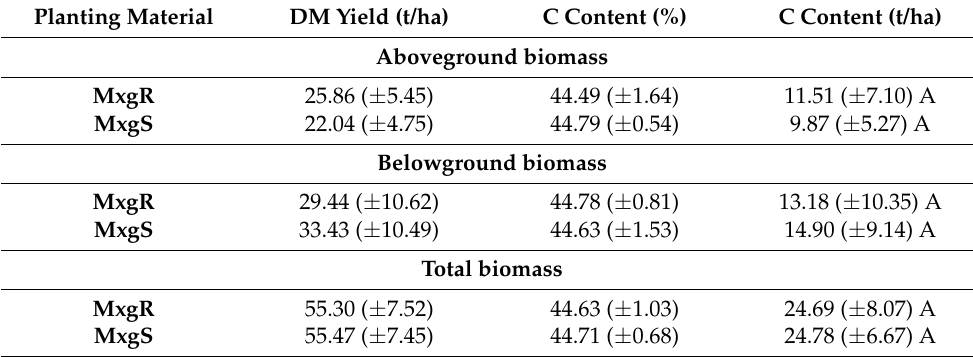
Table 1. Dry matter yield and carbon content in miscanthus biomass.